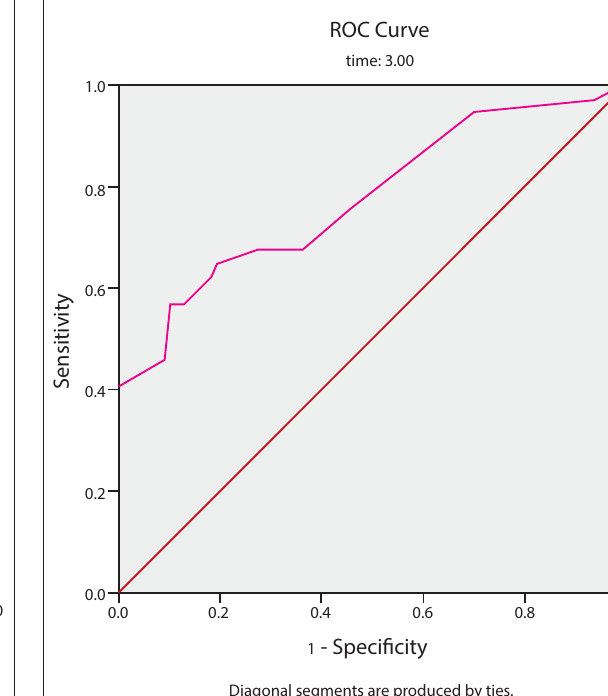
Diagonal segments are produced by ties. Fig. 2 ROC curve of SRSS scores for suicidal ideation three weeks post- diagnosis in HIV-infected adults.